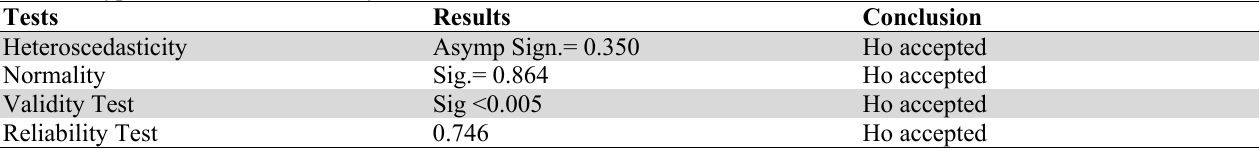
Classical Hypotheses and Data Quality Tests